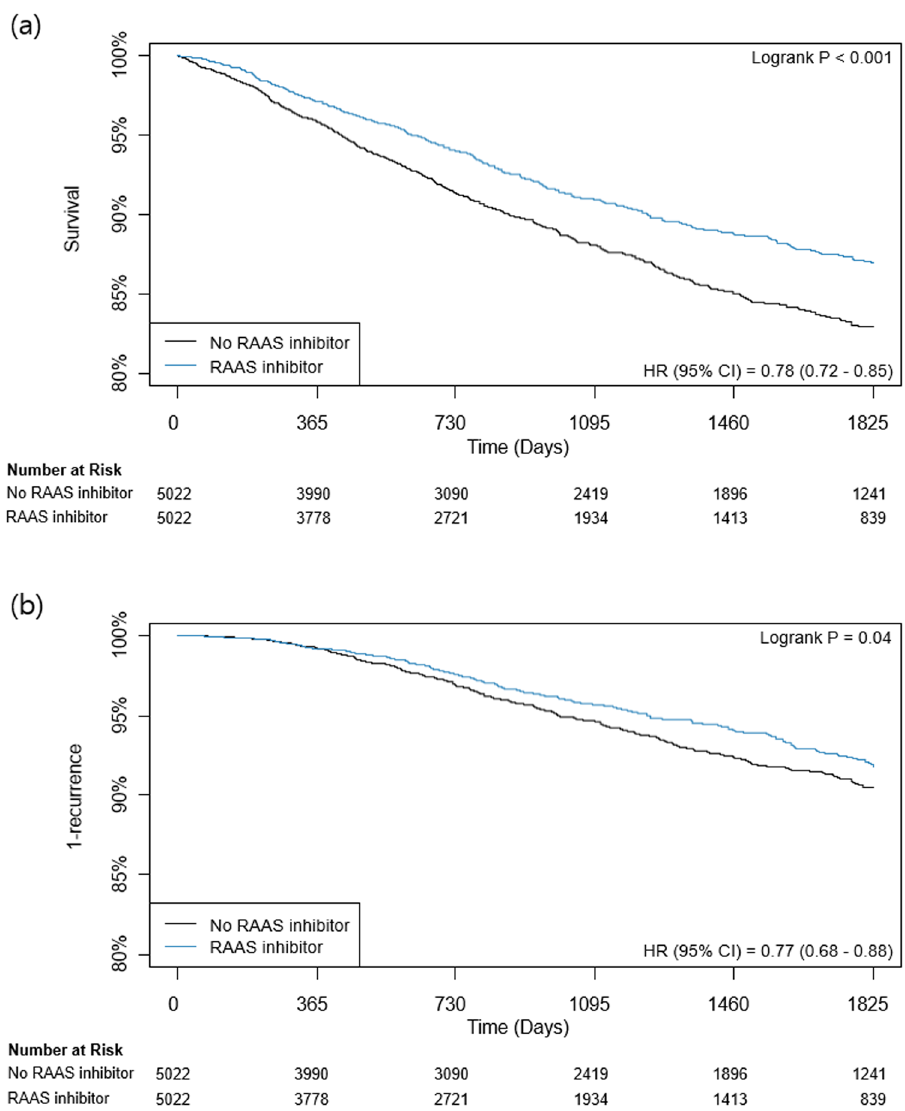
Figure 1. Kaplan–Meier Curves of ( a ) mortality and ( b ) recurrence according to use of RAAS inhibitors during 5 years after cancer surgery. RAAS renin–angiotensin–aldosterone system, HR hazard ratio, CI confidence